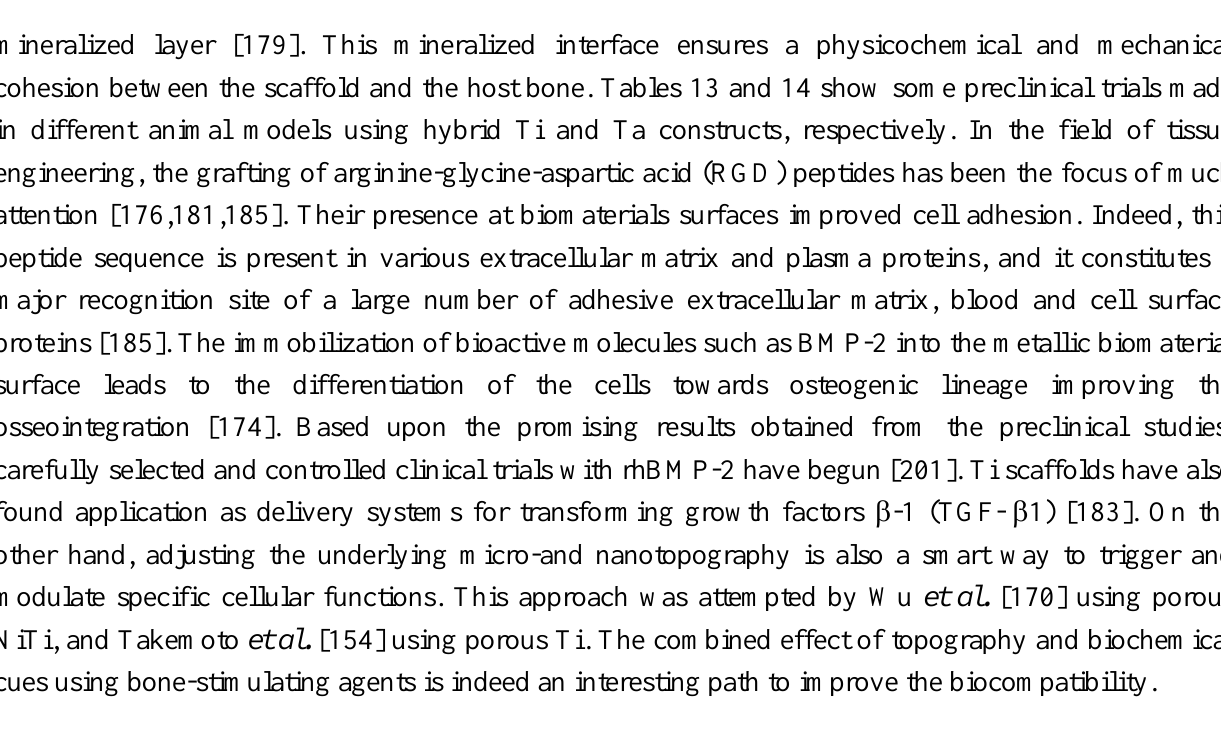
Table 13. Preclinical studies using titanium-ceramic, titanium-polymer, or cell loaded titanium